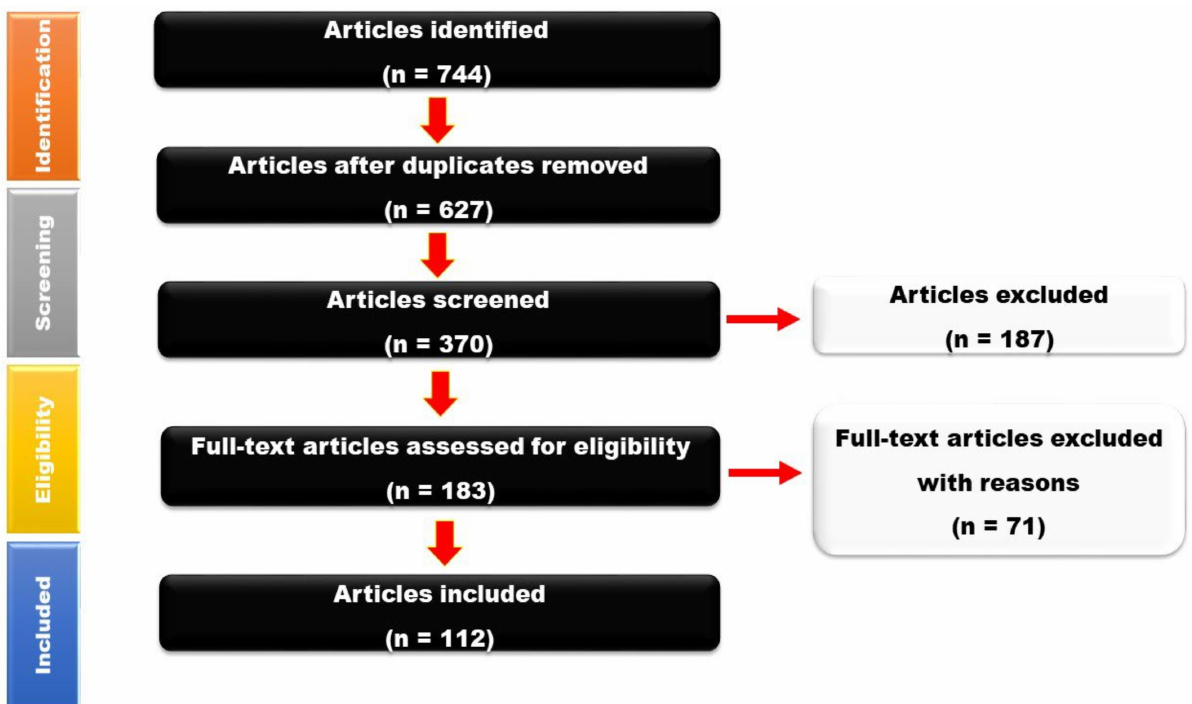
Figure 1. Flowchart showing the process of article